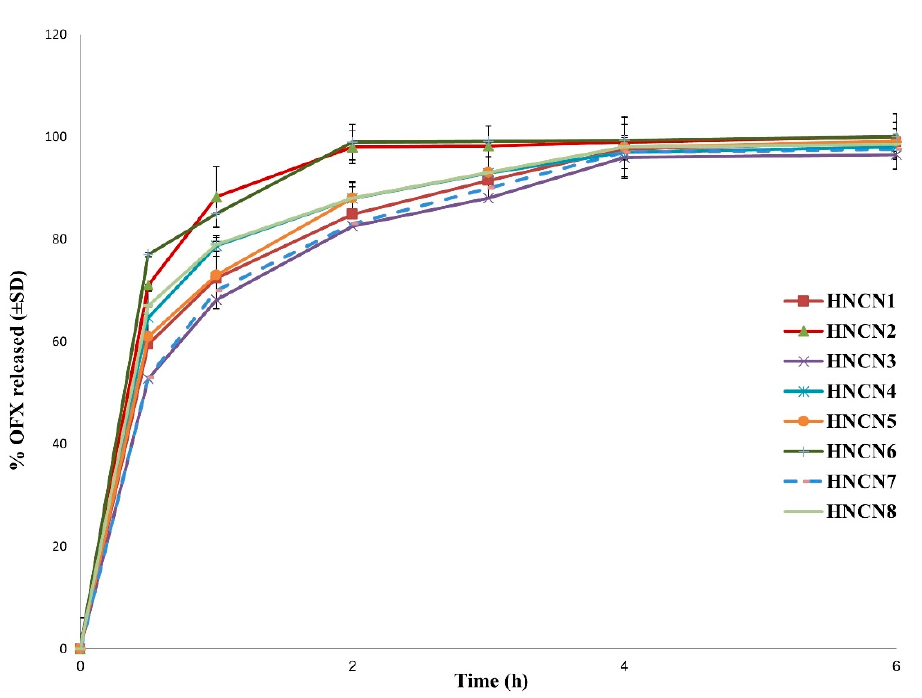
Figure 2. In-vitro OFX release profiles from different ofloxacin-loaded hybridized nanocellulose-lipid nanogels formulations (HNCNs) in phosphate buffer pH 7.4 at 37 °C. Table 3. Composition of the formulations based on 2 3 full-factorial design.